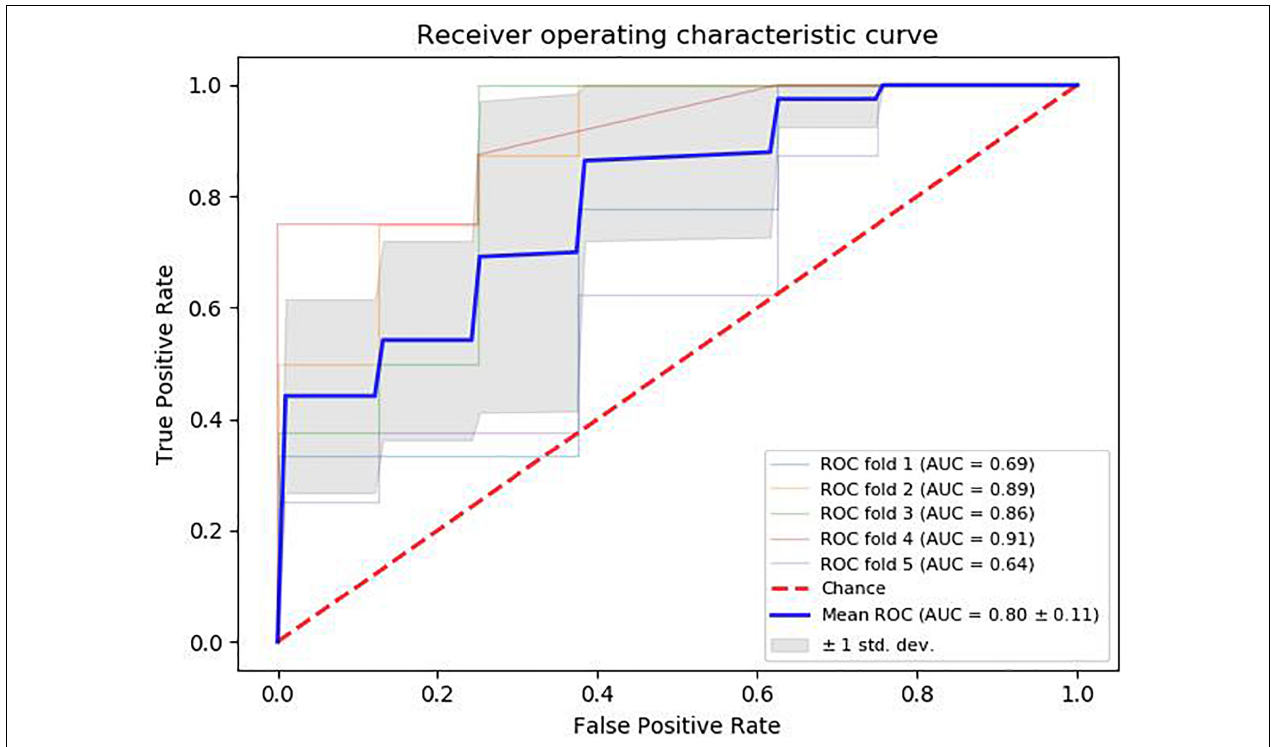
FIGURE 3 | ROC curves and AUC values are shown in the picture.